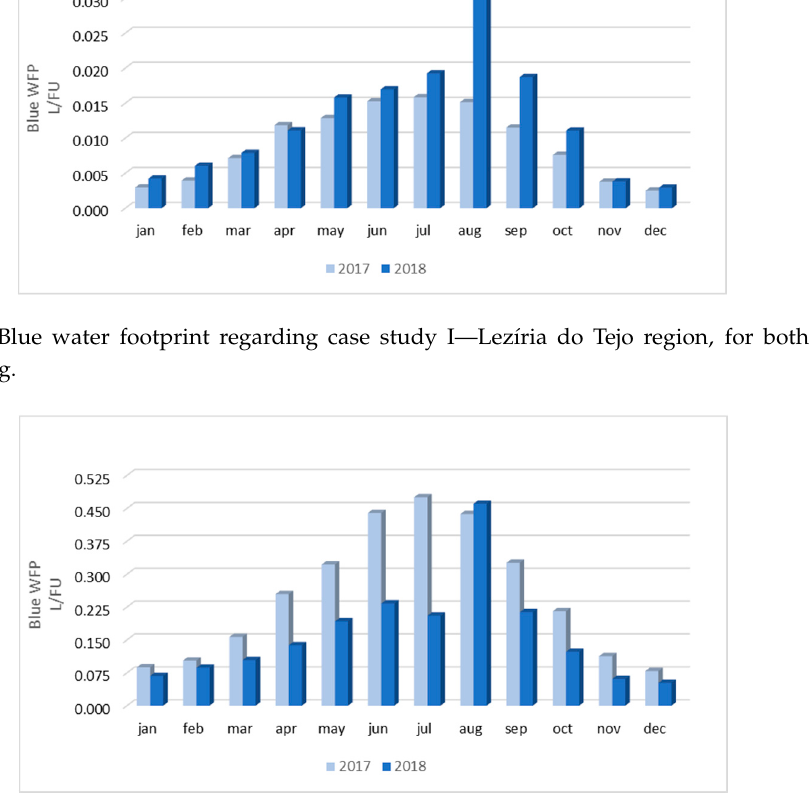
Figure 12. Grey water footprint regarding case study I—Lezíria do Tejo region, for both years of monitoring.